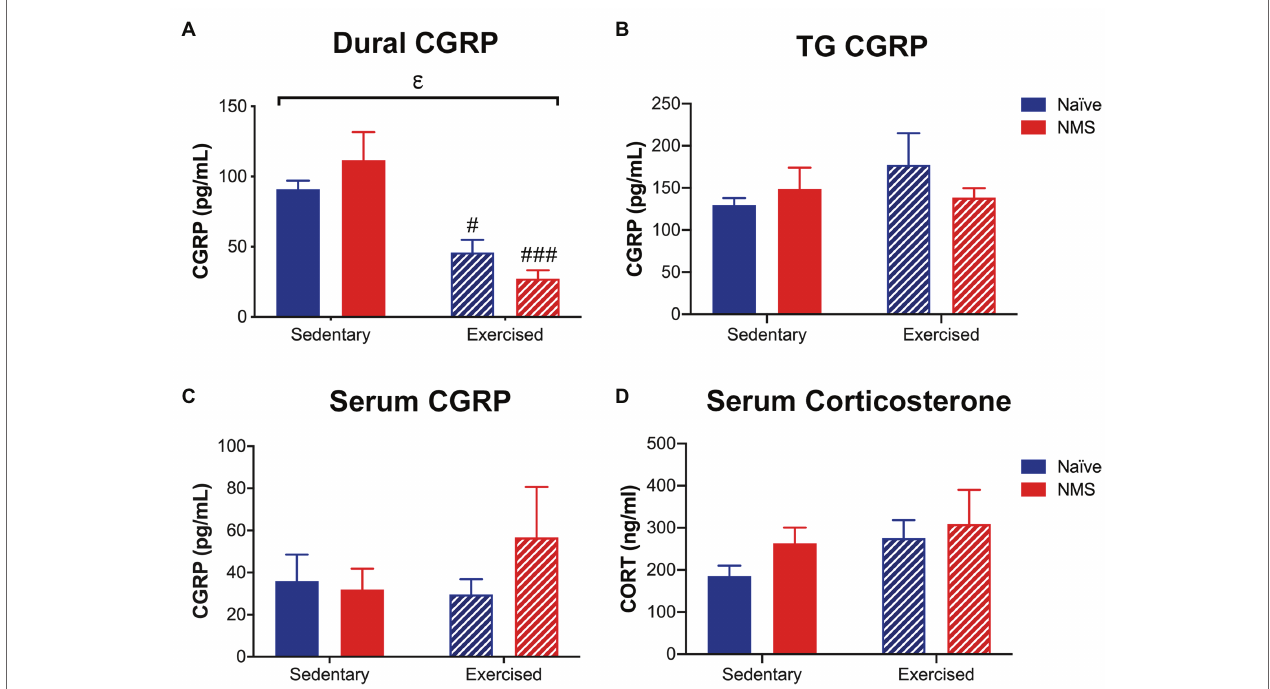
FIGURE 8 | Calcitonin gene-related peptide and corticosterone levels were measured in Sed and Ex naïve and NMS mice 2 h after nitroglycerin treatment. (A) CGRP content in the dura was significantly decreased by exercise, such that naïve-Ex and NMS-Ex mice had significantly lower CGRP protein levels compared to their sedentary counterparts. CGRP content in the TG (B) and serum (C) was not different between groups. (D) Serum corticosterone levels were also not significantly different between groups. Bracket indicates a significant effect of exercise ( ε p < 0.05) two-way ANOVA; #, ### p < 0.05, 0.001 vs. sedentary, Fisher’s LSD posttest. n =